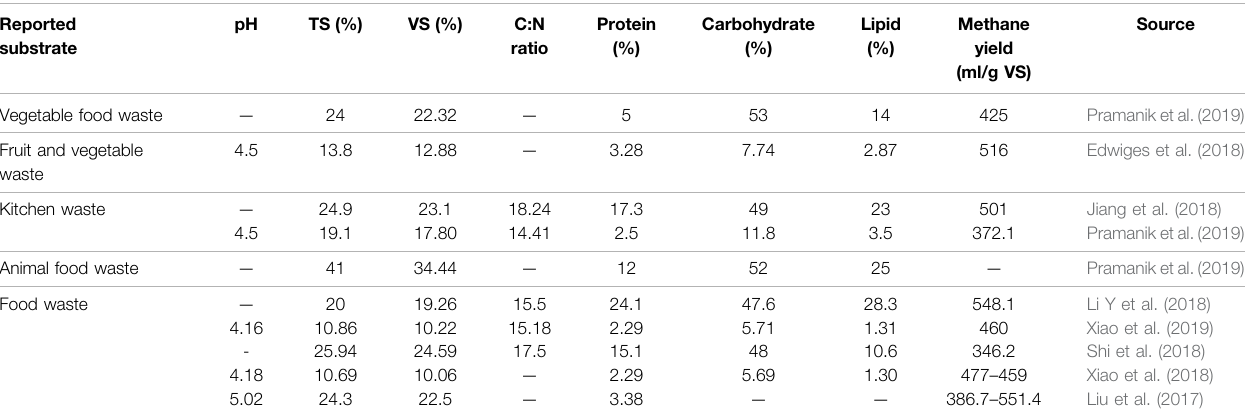
TABLE 1 | Characteristics of various food wastes and their biomethanation